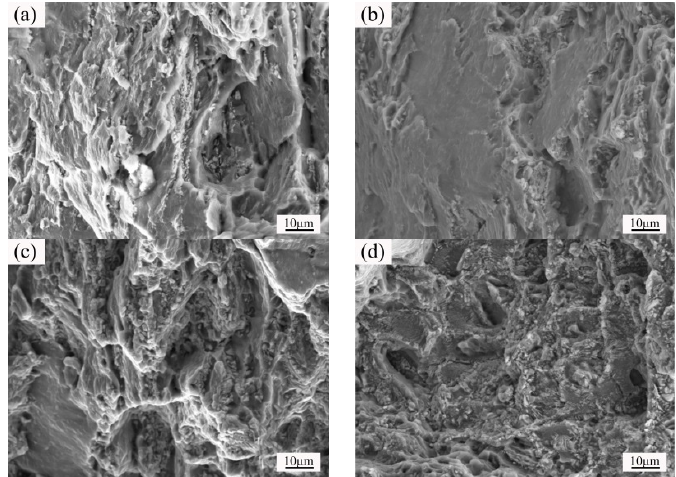
Figure 14. Fracture morphology of the isothermal forging parts at different temperatures of: ( a ) 320 °C, ( b ) 340 °C, ( c ) 360 °C, ( d ) 380 °C.